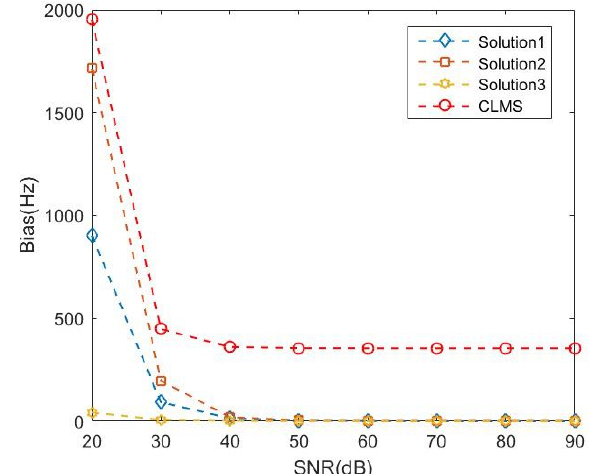
Figure 6. Bias analysis for frequency estimation using three solutions based on ACLMS algorithm and the CLMS algorithm.